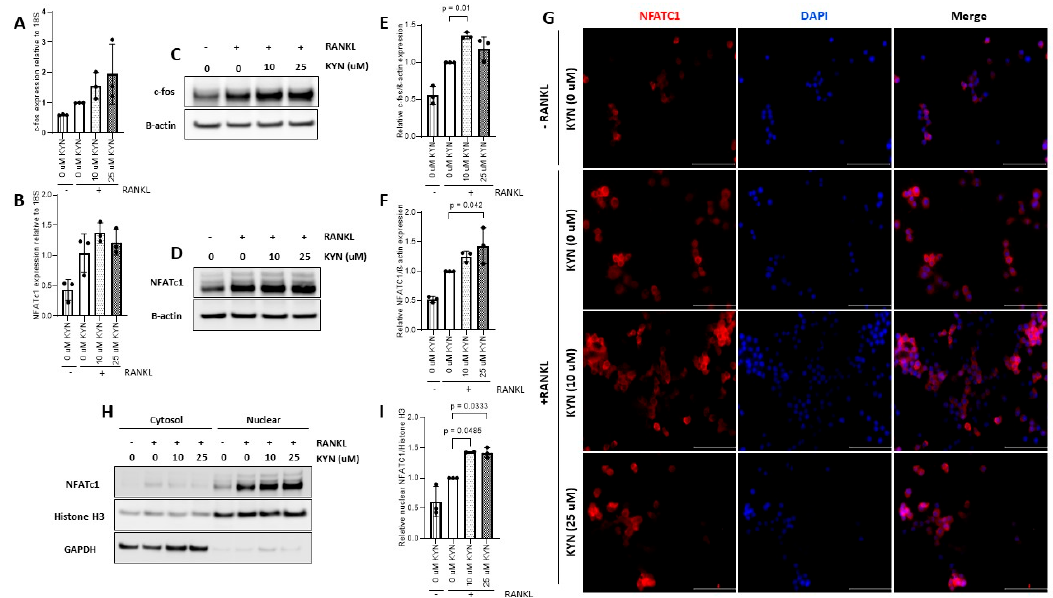
Figure 3. Kynurenine (KYN) treatment upregulates the expression of osteoclast differentiation markers c-fos and NFATc1. mRNA expression level of c-fos ( A ) or NFATc1 ( B ) in Raw 264.7 cells treated with KYN (10 or 25 μ M) in presence of RANKL for 24 h. Data are presented relative to RANKL-only (0 μ M KYN) control. Data are representative of three independent experiments and presented as mean ± SD. One-way ANOVA test was applied. Representative Western blotting of c-fos ( C ) or NFATc1 ( D ) proteins in Raw 264.7 cells treated with KYN (10 or 25 μ M) in presence of RANKL for 24 h. ( E ) Densitometric analysis of c-fos protein expression in ( C ). ( F ) Densitometric analysis of NFATc1 protein expression in ( D ). Data are expressed as c-fos/ β -actin or NFATc1/ β -actin ratio relative to RANKL-only (0 μ M KYN) control. Data are representative of three independent experiments and presented as mean ± SD. One-way ANOVA test was applied. ( G ) Immunocytochemistry analysis of Raw 264.7 cells treated with KYN (10 μ M or 25 μ M) in presence of RANKL for 24 h using NFATc1 (red) antibody. Nuclei were visualized using DAPI (blue). Images are representative of two independent experiments. Images were taken at 40X objective magnification with scale bar indicated. ( H ) Representative Western blotting of cytoplasmic and nuclear fractions of NFATc1 in Raw 264.7 cells treated with KYN (10 or 25 μ M) in the presence of RANKL for 24 h. Histone H3 was used as nuclear marker and GAPDH was used as cytoplasmic marker. ( I ) Densitometric analysis of nuclear NFATc1 localization. Data are expressed as NFATc1/Histone H3 ratio relative to RANKL-only (0 μ M KYN) control. Data are representative of three independent experiments and presented as mean ± SD. A one-way ANOVA test was applied.